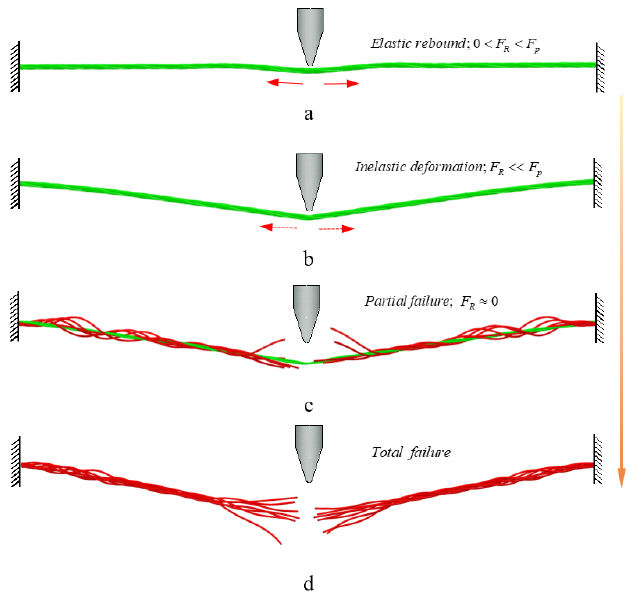
Figure 15. Failure sequence of strands with the increase of impact energy: ( a ) elastic rebound with slight pre − stress loss; ( b ) inelastic displacement with partial loss of pre − stress; ( c , d ) partial or total failure of wires underneath the indenter with entire pre − stress loss.